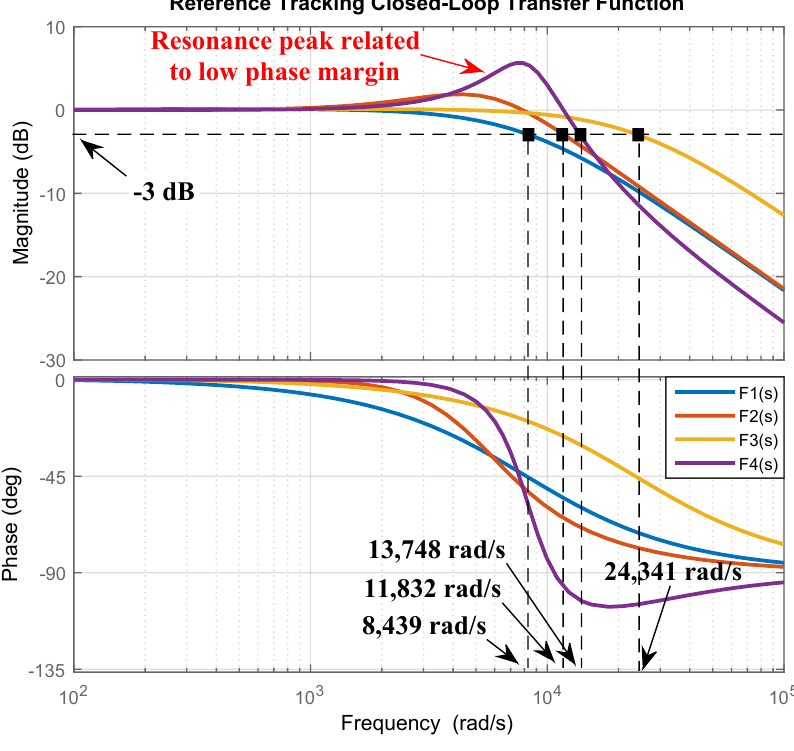
Figure 9. Bode plot of the reference-tracking closed-loop transfer